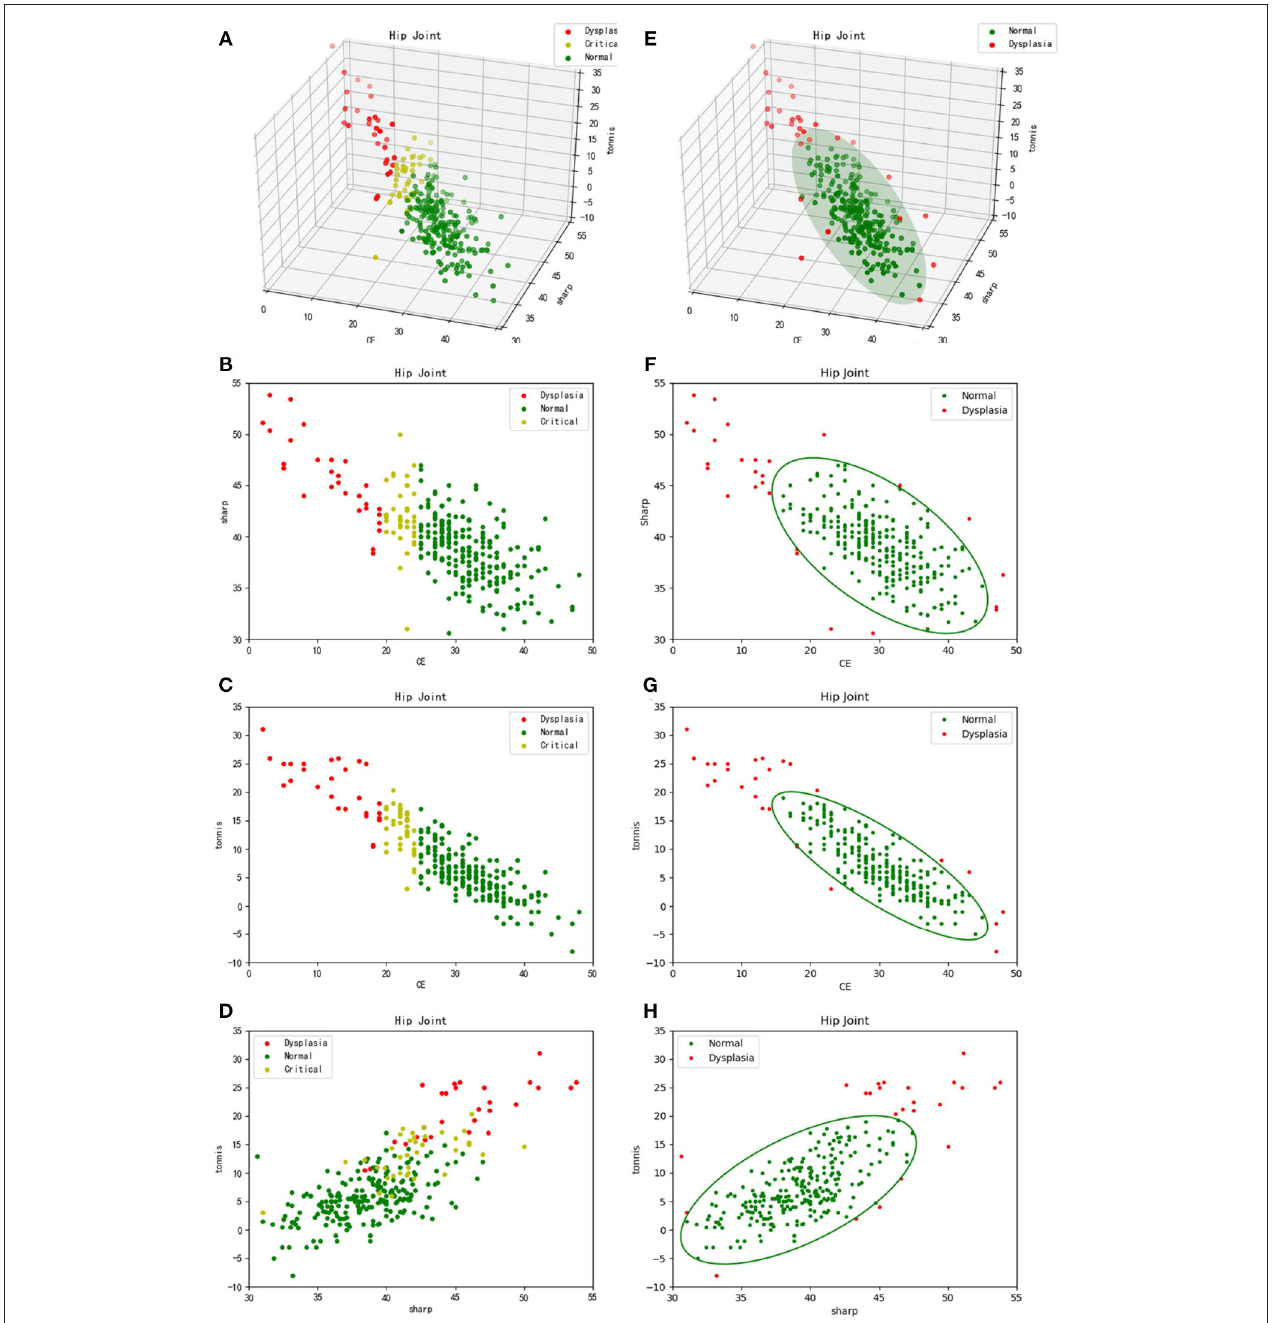
FIGURE 5 | Three-dimensional scatter plots and their two-dimensional projection results. (A–D) refer to the traditional diagnosis of hip dysplasia deriving from knowledge-driven clinical manual in a three-dimensional space and its two-dimensional projection subspaces, respectively. Therefore, θ CE is to be considered. That is, samples labeled with different colors are derived from different θ CE scopes. (E–H) correspond to the new data-driven criterion for diagnosis of hip dysplasia in a three-dimensional space and its two-dimensional projection subspaces, respectively. The ellipsoid and corresponding projection ellipses refer to the parametric